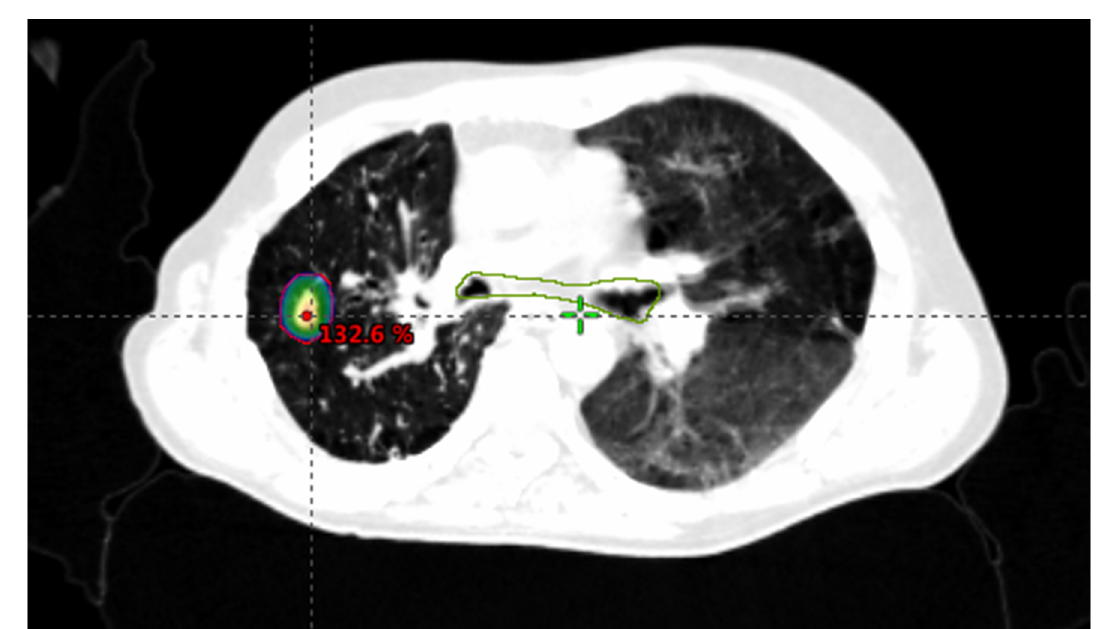
Figure 1. Lung metastases from CRC. Planning treatment: Dose: 60 Gy in 3 fractions. DBE: 150 Gy.